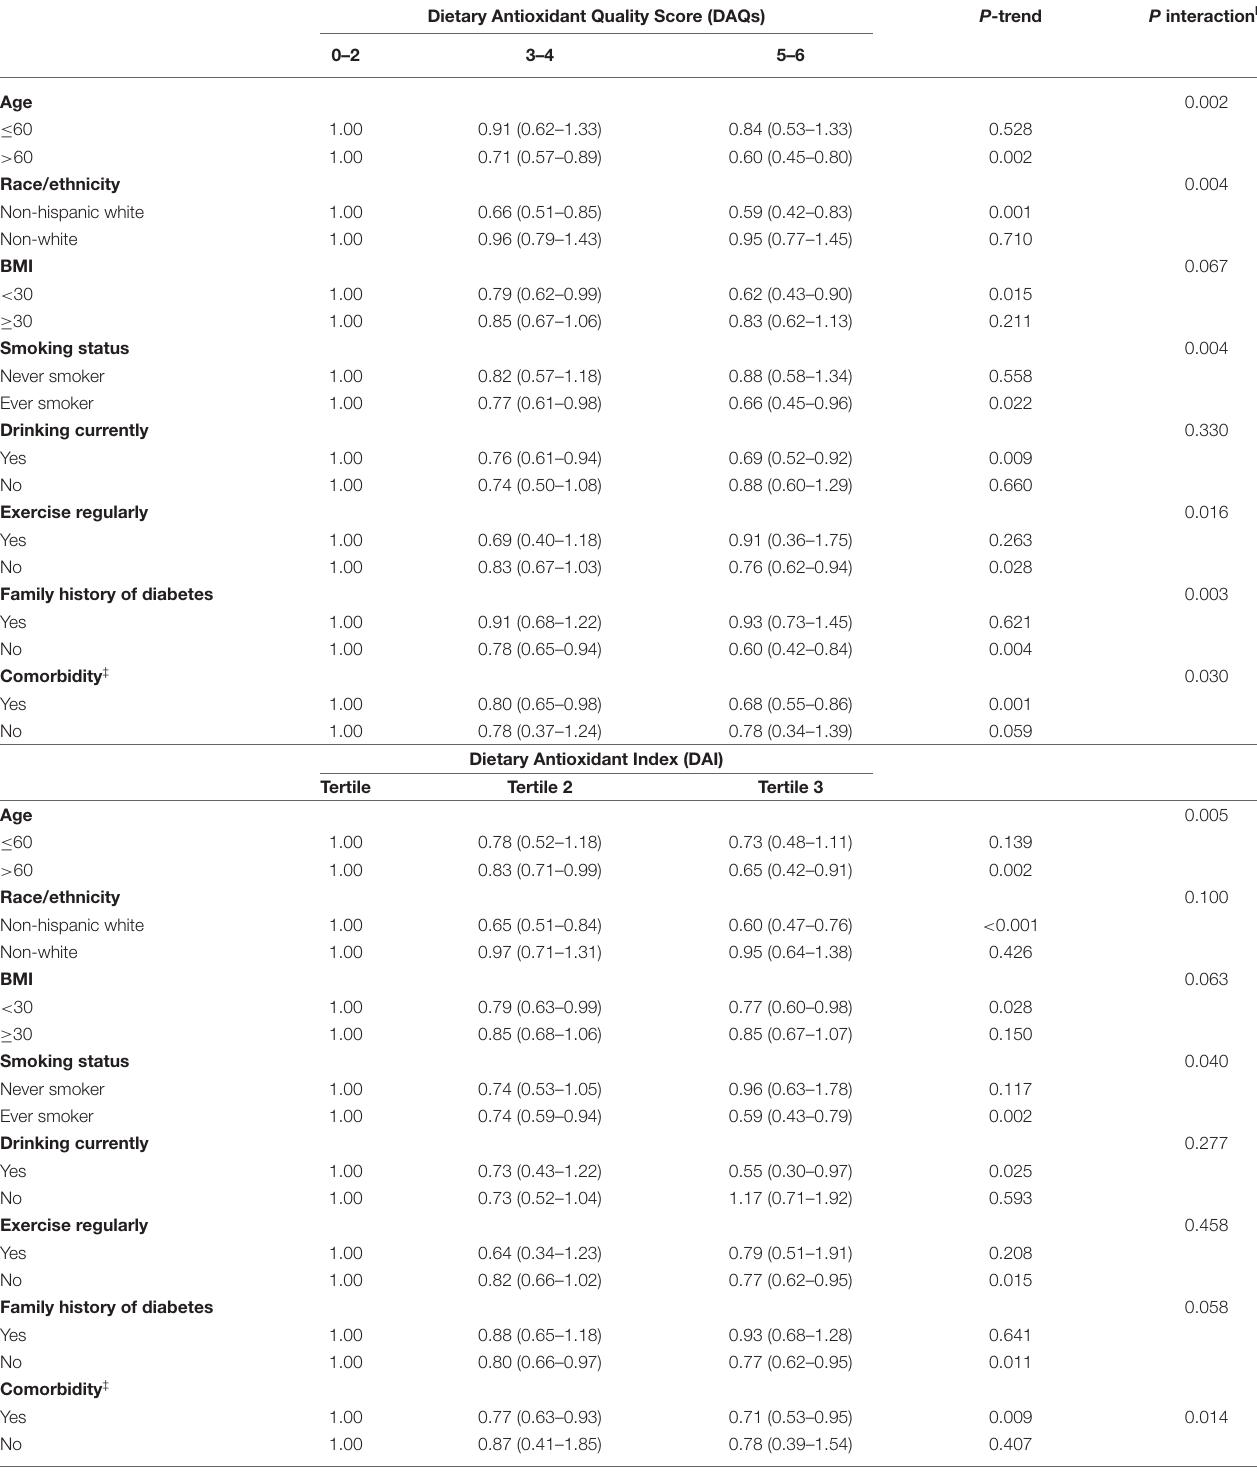
TABLE 3 | Association of the Dietary Antioxidant Quality Score (DAQS) or the Dietary Antioxidant Index (DAI) with all-cause mortality among adults with diabetes in the National Health and Nutrition Examination Survey (2003–2014), stratified by selected patients’ characteristics a . Dietary Antioxidant Quality Score